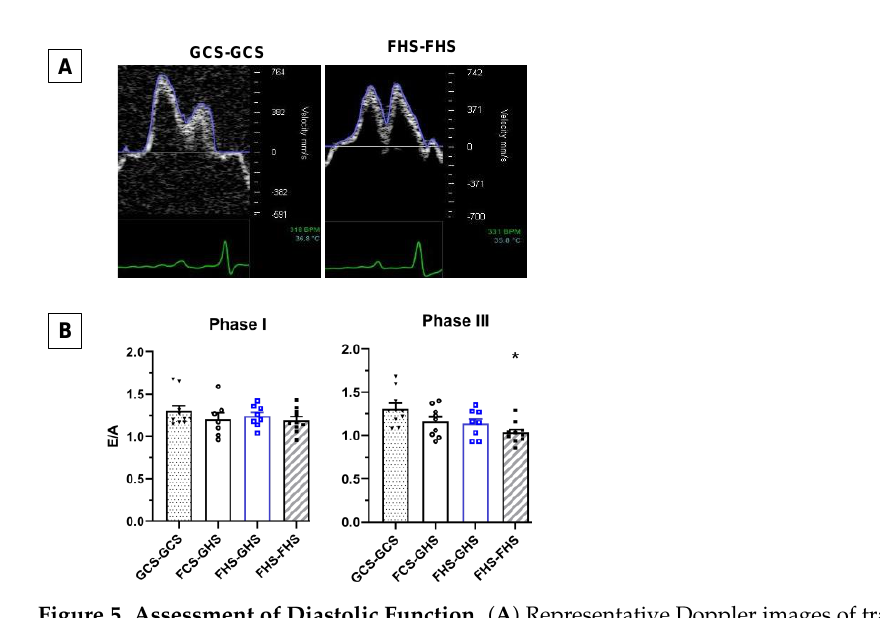
Figure 5. Assessment of Diastolic Function. ( A ) Representative Doppler images of transmitral flow patterns from GCS-GCS and FHS-FHS rats at the end of Phase III. ( B ) Ratio of early (E-wave) to late (A-wave) left ventricular filling (E-wave) left ventricular filling as index of diastolic function. Group labels are as described in the legend for Table 1. Values are the mean ± SE; n as indicated per group, * p < 0.05 vs. GCS-GCS. Table 5. Echocardiographic Parameters Associated with Diastolic Function at the End of Phase